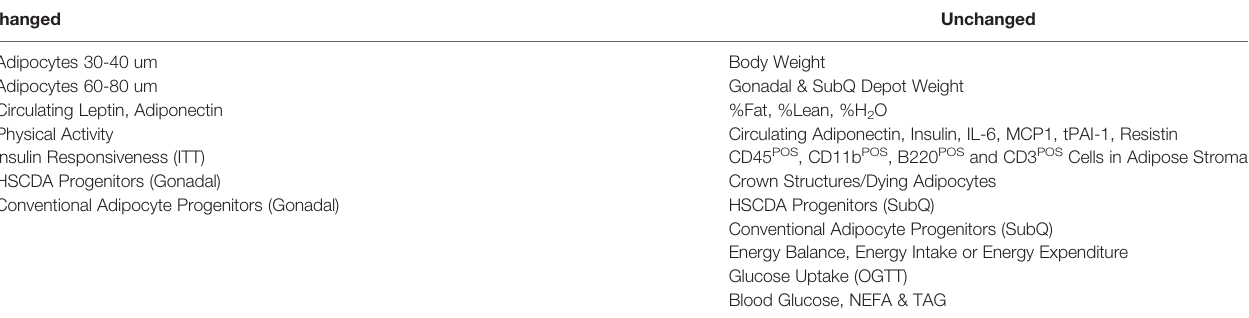
TABLE 1 | Morphological, Physiological and In fl ammatory Changes Elicited by Blockade of HSCDA